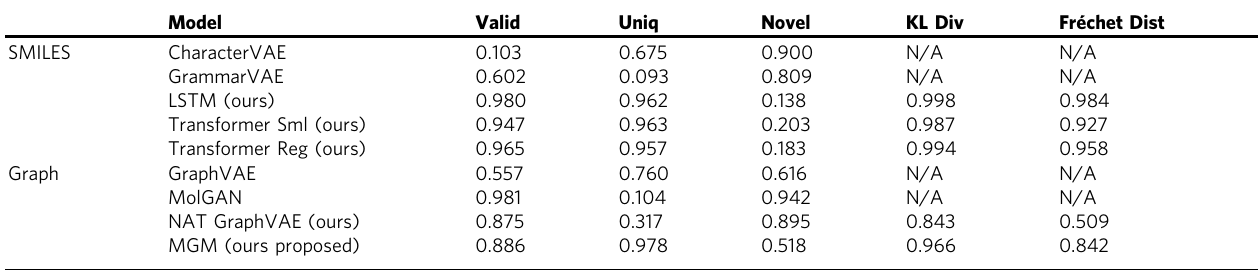
Table 3 Distributional results on QM9. CharacterVAE 49 , GrammarVAE 50 , GraphVAE 23 and MolGAN 51 results are taken from Cao and Kipf 51 .